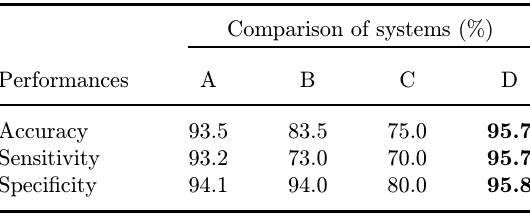
Table 3. Comparison between the existing analysis systems and the proposed system results. Comparison of systems